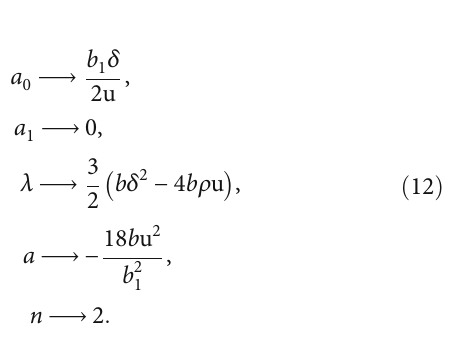
ffiffiffiffiffiffiffiffiffiffiffiffiffiffiffiffiffi p ffiffiffiffiffiffiffiffiffiffiffiffiffiffiffiffiffi 4 ρ u − δ 2